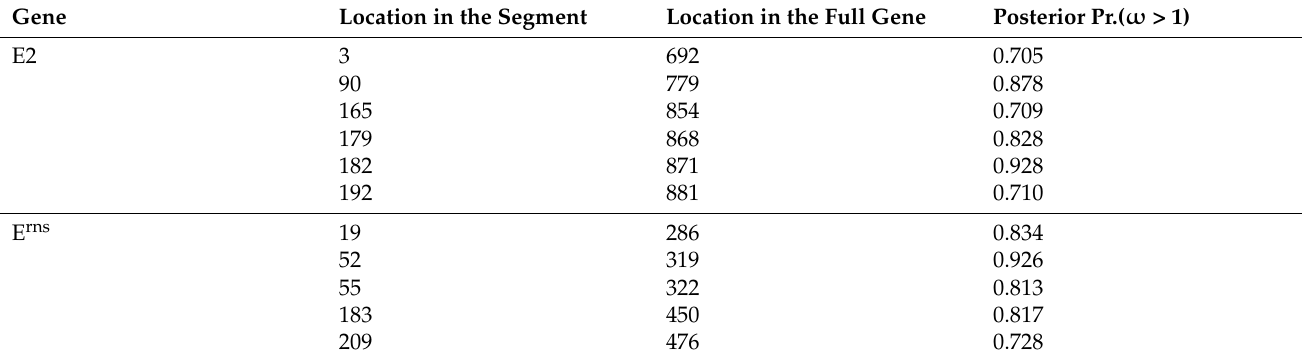
Table 5. The sites of E2 and E rns under potential positive selection in the likelihood ratio test of Model A. Gene Location in the Segment Location in the Full